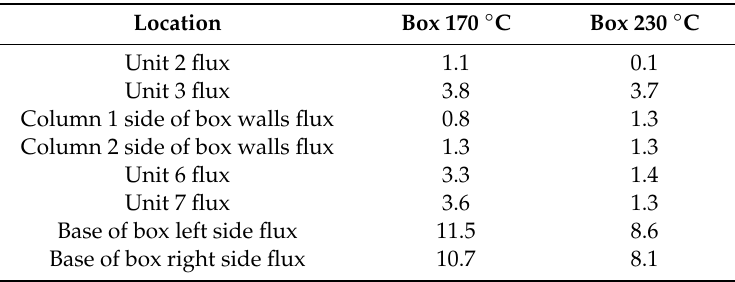
Table 12. Comparison of sticky e ff ects between 170 and 230 ◦ C (experimental averages using repeated runs with no air leaks). Fluxes are given in units of g / m 2 /